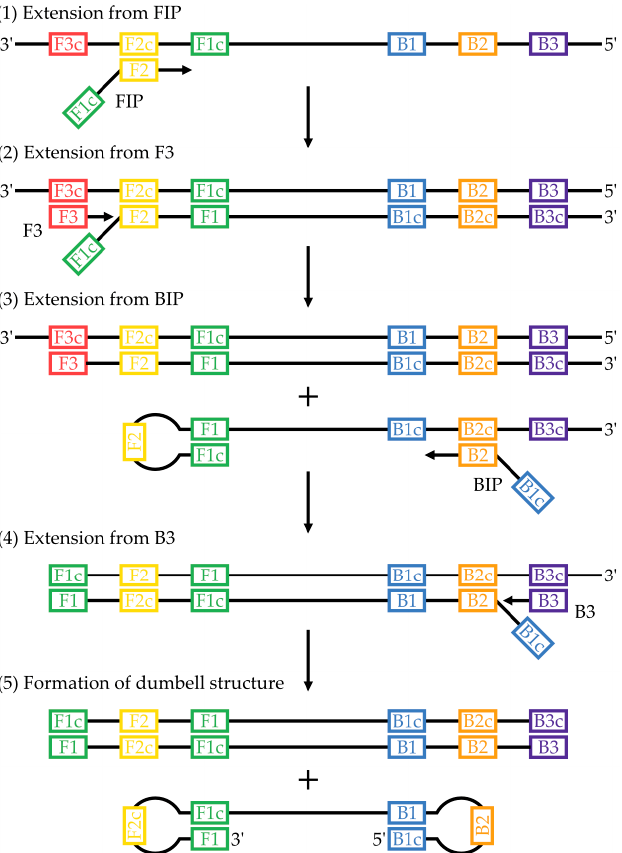
Figure 1. Mechanism of LAMP up to the formation of the dumbbell structure. (1) The F2 region of primer FIP hybridizes to the F2 region of the template, and replication is initiated. This introduces a region of self-complementarity in the newly synthesized strand. (2) Extension from primer F3 displaces the previously synthesized strand. (3) B2 of BIP hybridizes with B2c of the displaced strand and replication occurs. (4) Extension from B3 displaces the previously synthesized strand. (4) The self-complementary regions form a self-priming dumbbell structure that feeds into the cycling and elongation phases of LAMP. Figure is adapted from [22,23], which also provide a detailed explanation of the entire LAMP